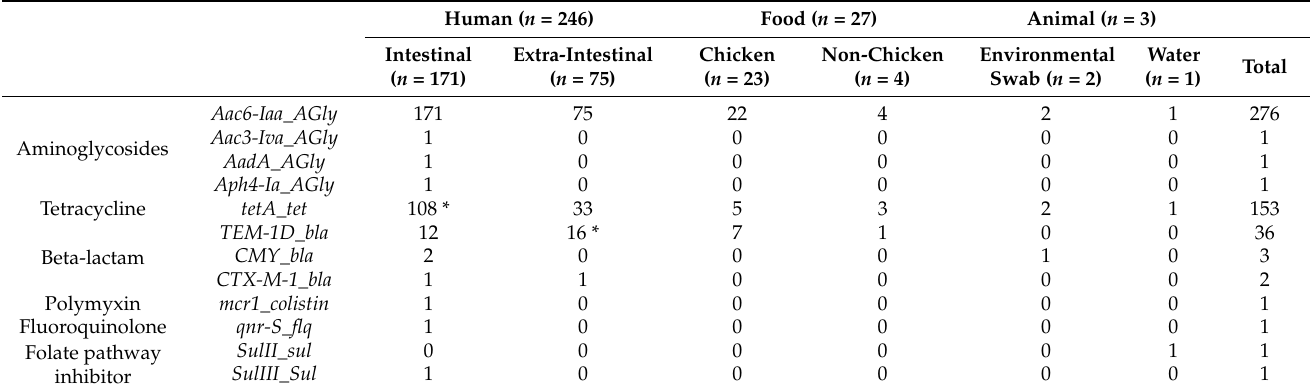
Table 2. Antimicrobial resistance-related genes in S . Enteritidis isolates ( n = 276). Human ( n = 246) Food ( n = 27) Animal ( n = 3) Intestinal Extra-Intestinal ( n = 171) ( n =